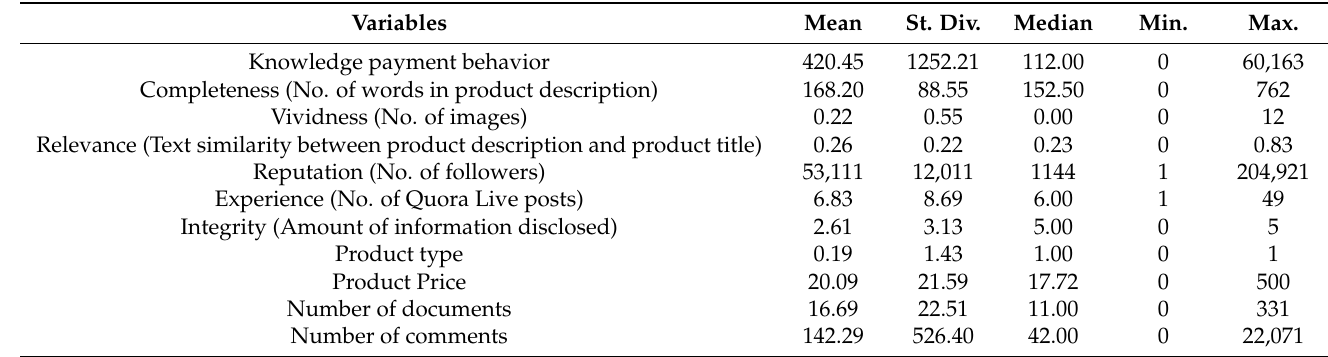
Table 4. Descriptive statistics of study variables.